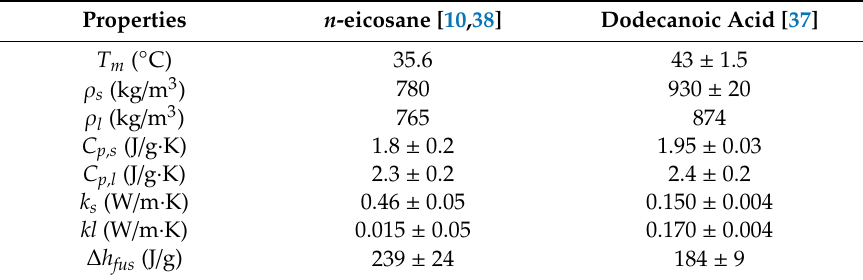
Table 2. Physical properties of the PCM used in the experiments.